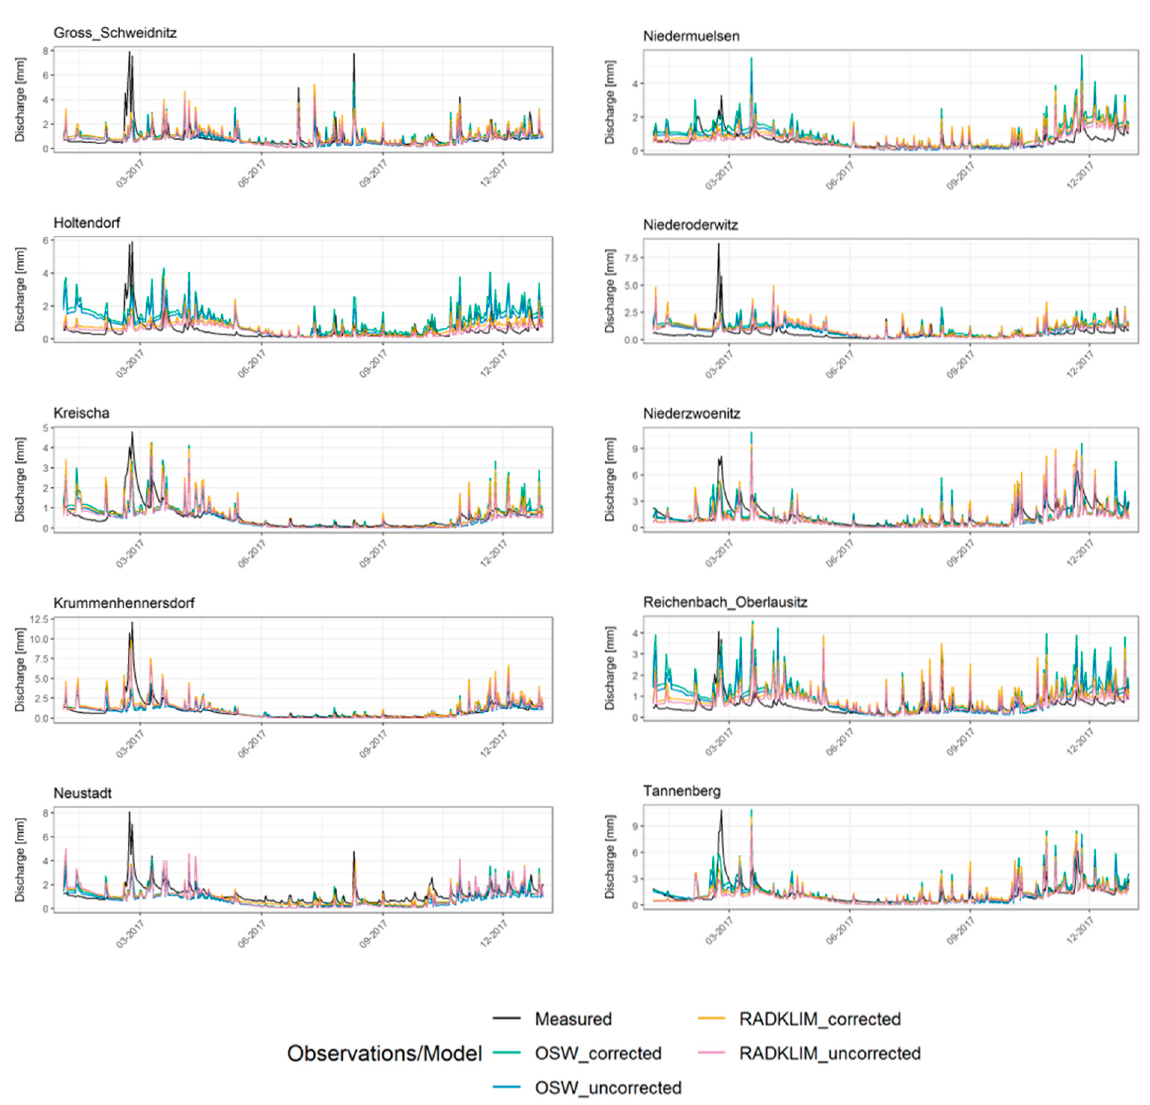
Figure 10. Exemplarily results of simulated (weighted mean from all HRUs) runoff derived from four different precipitation datasets (OSW uncorrected, OSW corrected, RADKLIM uncorrected, and RADKLIM corrected) compared to the observations for the ten selected catchments, exemplary for 2017.